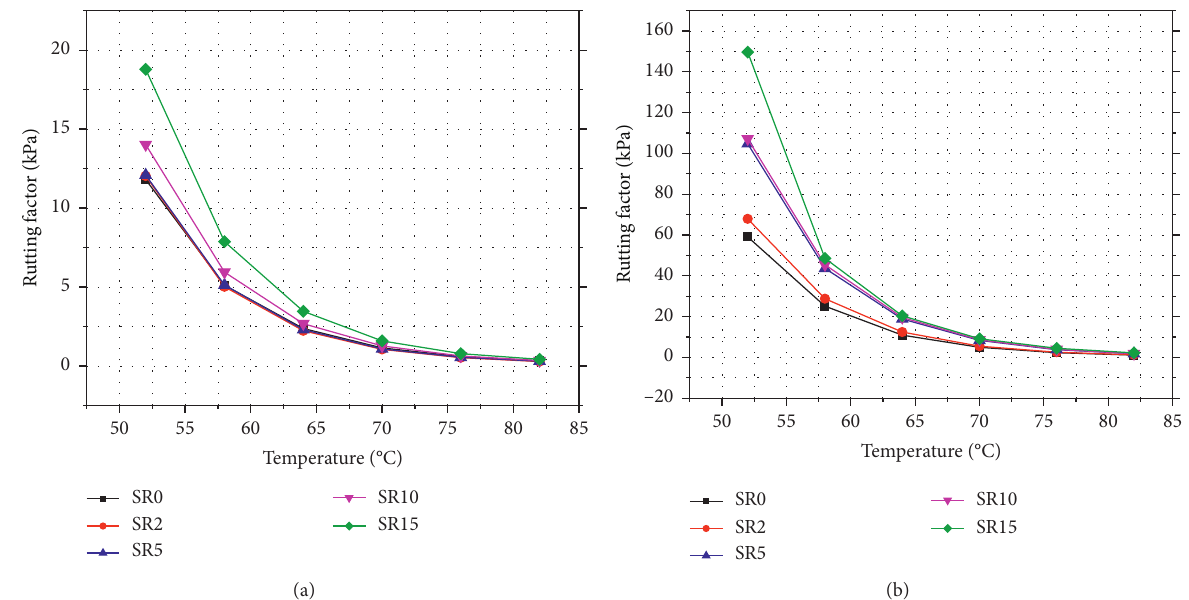
Figure 9: Rutting factor of different asphalt binder type: (a) the unaged; (b) the Table 4: Single factor analysis of variance of rutting factor under different temperatures. Asphalt aged